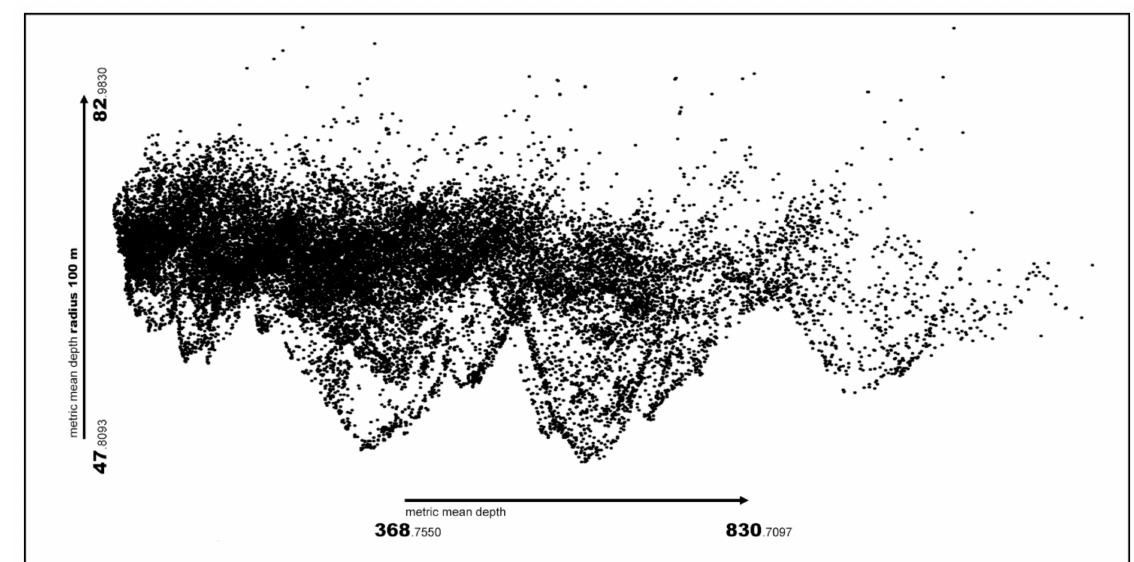
Figure 5. Background patchwork analysis of BaSECo with metric mean depth radius 100 (Y-axis).